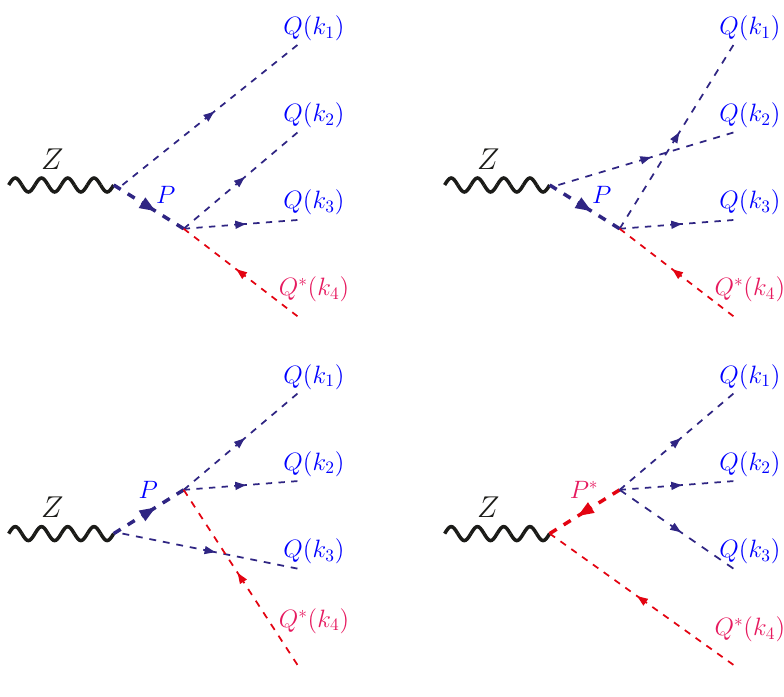
Figure 2 . Feynman diagrams for Z